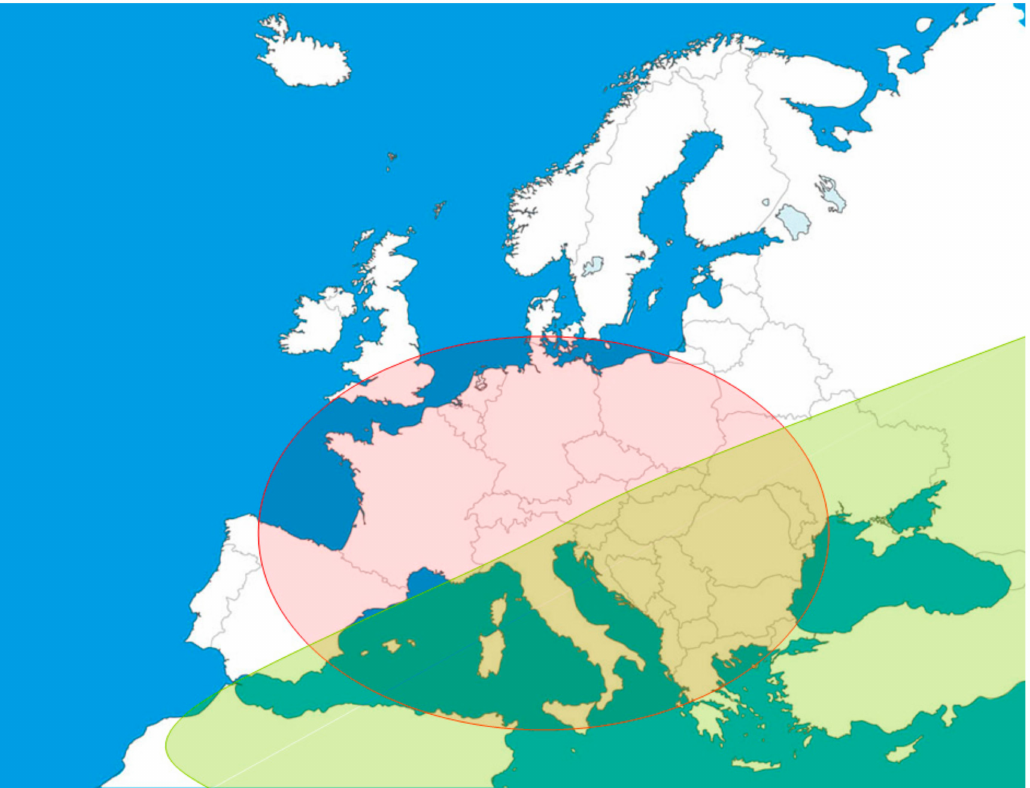
Figure 1. Geographic distribution of WNV (green) and USUV (red) in Europe. Co-circulation, paired with antigenic similarity and overlapping clinical expression of the infections, complicates the diagnosis of febrile conditions, leading to suboptimal case management. More importantly, this may directly alter the epidemiology of these viruses. This was shown in California, after the introduction of WNV caused the displacement of Saint Louis encephalitis virus (SLEV), and in Thailand, with an increased severity of dengue virus (DENV) infection symptoms in individuals with previous JEV infection